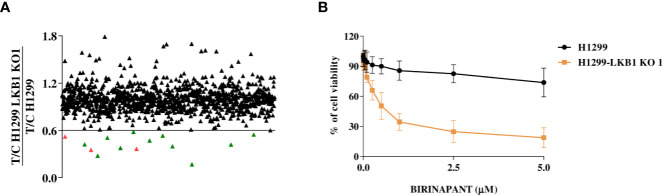
(A), Distribution of the FDA-approved drug library’s compounds according to their different activity in H1299 and H1299 LKB1 KO 1 cells. Y-axis refers to H1299-LKB1 KO 1 T/C and H1299 T/C ratio. Each single triangle represents a compound. The eleven hit compounds are below the chosen cut-off value of 0.6 and they are colored in green. The three excluded compounds are in red. (B) Dose-response curves of H1299 and H1299-LKB1 KO 1 isogenic system treated with increasing concentrations of Birinapant. The response to the drug was evaluated with MTS assay. The average of three independent experiments is reported. Statistical analysis was carried out through two-way ANOVA and Bonferroni post-test for multiple comparisons and it is reported in Supplementary Table 2.